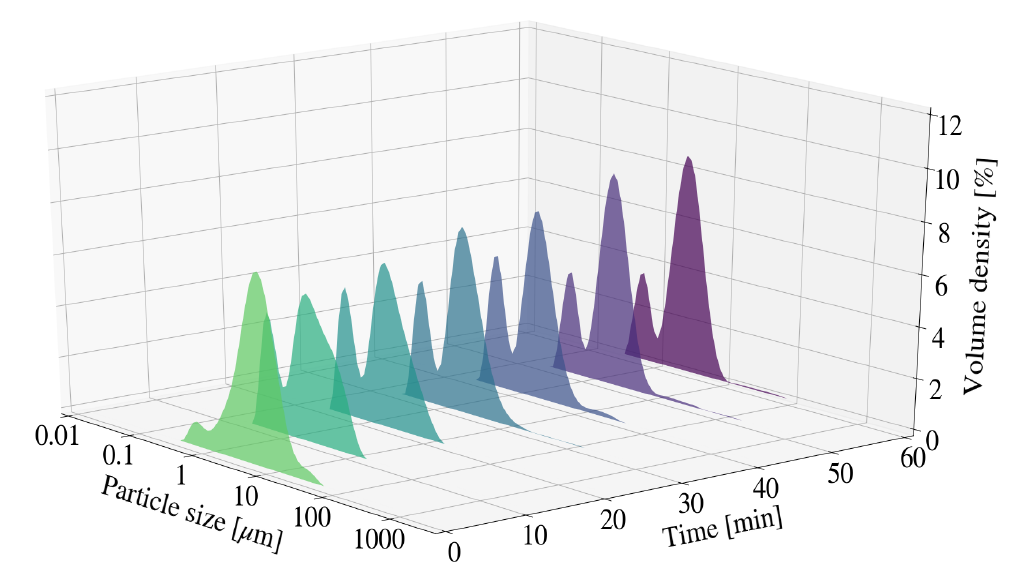
Figure 7. Particle size distribution for Mg-Al LDH samples synthesised at a cooling water inlet temperature of 50 °C, with a change in media size